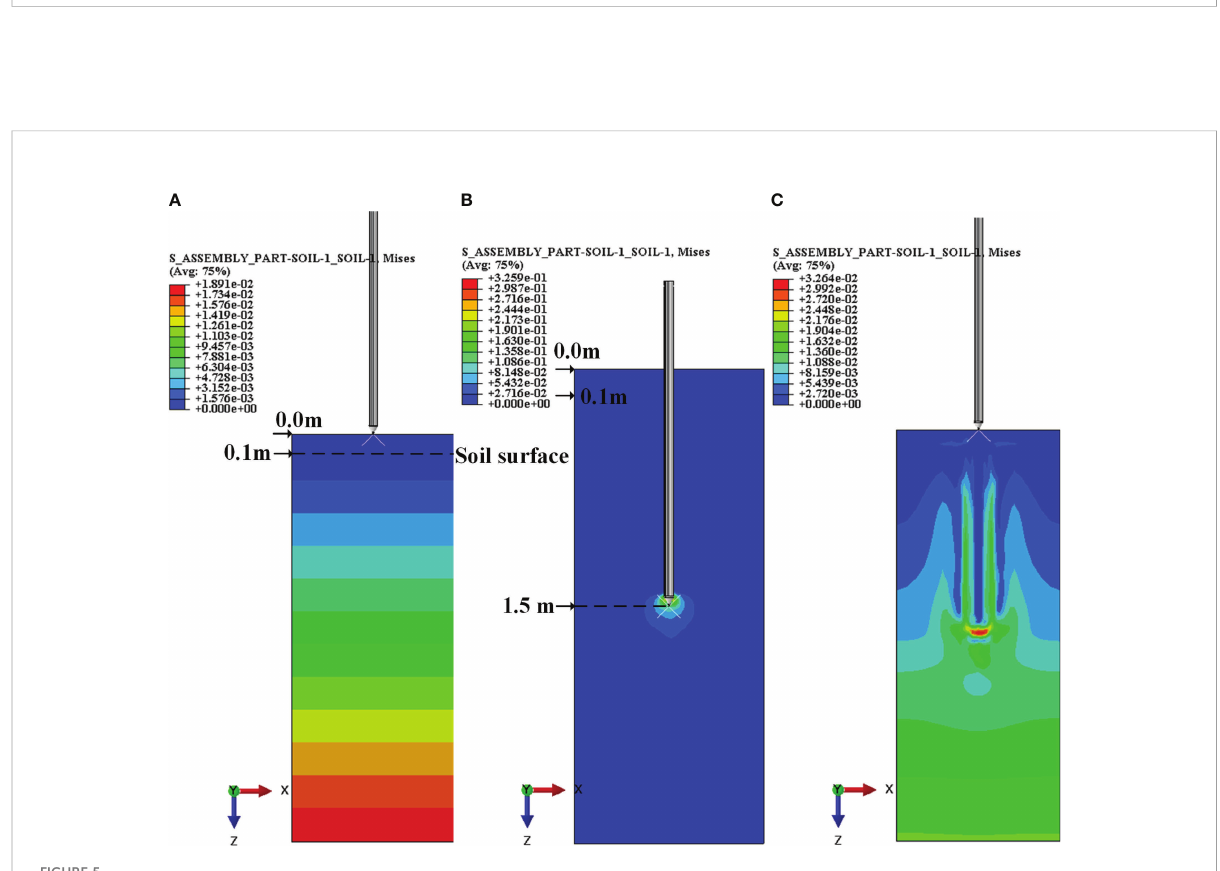
FIGURE 5 Mises stress contour in CEL analysis (A) at the initial state; (B) at a penetration depth of 1.5 m; and (C) after deployment.